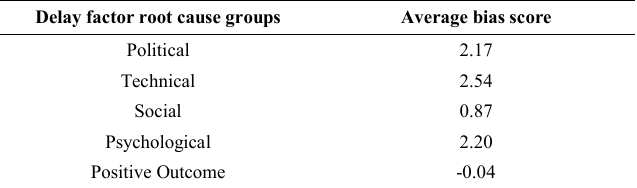
Table 3. Average bias score base on the delay factor grouping.